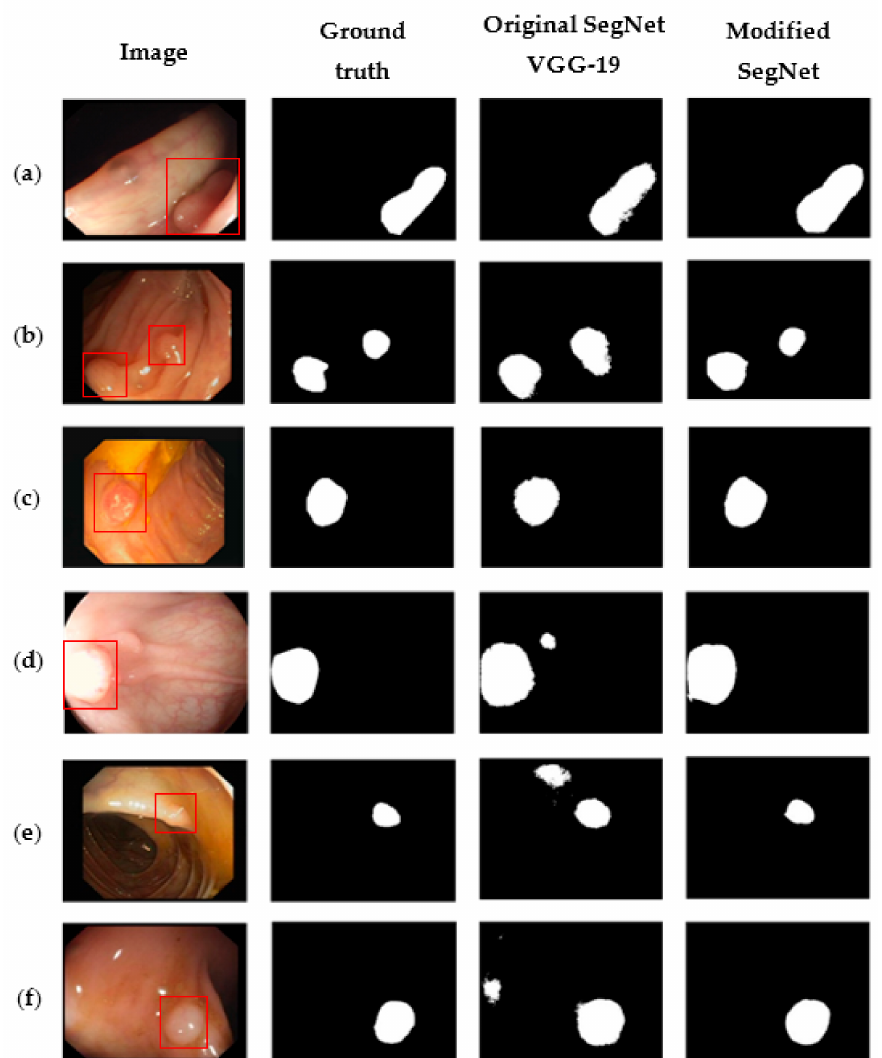
Figure 3. Comparative examples of polyp segmentation results. The first column contains raw images, the second column contains the reference ground truths, the third column shows the segmentation results from the original SegNet VGG-19, and the final column shows the segmentation results from our modified SegNet. The red boxes in the raw images ( a – f ) indicate the location of polyps. The white patches in the second, third, and final columns indicate the segmented polyps, the black areas indicate the non-polyp